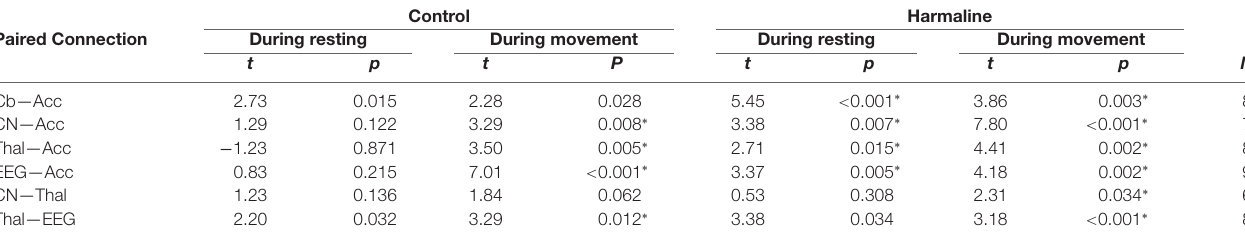
TABLE 1 | Surrogate analysis of coherence at the tremor frequency (9–15 Hz). Control Harmaline Paired Connection During resting During movement During resting During movement t p t P t p